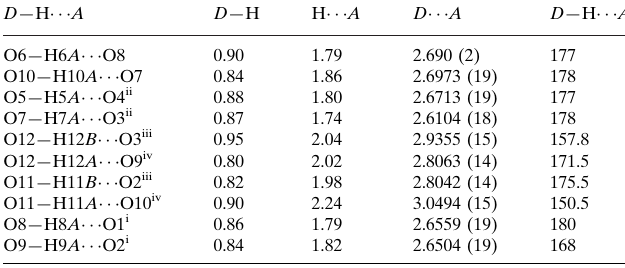
Hydrogen-bond geometry (A˚ , (cid:5)